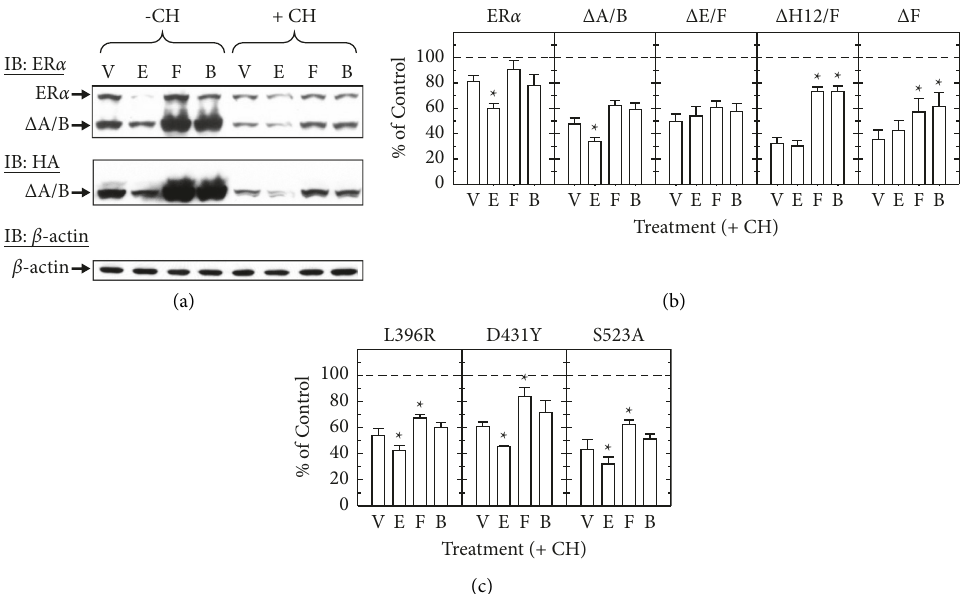
Figure 4: Forskolin protects both endogenous and transfected ER α from ligand-induced degradation in GH3 cells. (a) Cells transfected with HA-tagged ER α with the deletion of A/B ( Δ A/B, 400ng) were pretreated with either vehicle (-CH) or cycloheximide (+CH, 20 μ g/ml) for 30min, followed by vehicle (V), estradiol (E, 10 nM), forskolin (F, 1 μ M), or both (B) for 6h. Representative images show endogenous ER α and Δ A/B detected by immunoblotting (IB) with the ER α antibody (upper panel), but only Δ A/B detected specifically by the HA antibody (middle panel). Similar amounts of β -actin were revealed using β -actin antibody (lower panel). (b) Cells transfected with HA-tagged mutated ER α with deletion of A/B ( Δ A/B), E/F ( Δ E/F), F ( Δ F), and helix 12/F ( Δ H12/F) (400 ng) were similarly pretreated with cy- cloheximide, followed by vehicle (V), estradiol (E), forskolin (F), or both (B) for 6h. Additional groups of control cells, similarly transfected with different HA-tagged ER constructs, were pretreated with vehicle (no cycloheximide) and collected in parallel, and their ER levels were used for normalization (set as 100%; dash lines). Endogenous ER α and HA-tagged deleted ER α were detected by the ER α and HA antibodies, respectively. (c) Cells transfected with HA-tagged, mutated ER α Δ A/B (L396R, D431Y, or S523A) were similarly pretreated with cy- cloheximide (+CH) and then received either vehicle (V), estradiol (E) , forskolin (F), or both (B) and immunoblotted (IB) for HA and β -actin. Protein levels (mean ± SEM) of endogenous or transfected ER were normalized to the levels of β -actin and expressed as a percentage of the vehicle controls without cycloheximide (as 100%; dash line) from at least three experiments. ∗ depicts significantly altered ER levels over vehicle-treated controls with the same ER expression vector (V) ( P < 0 .